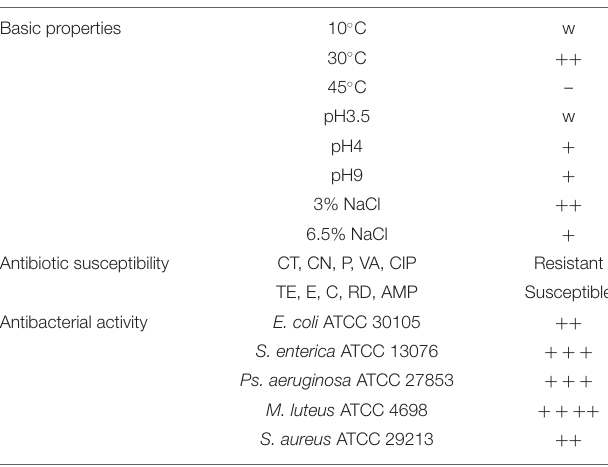
TABLE 1 | L. casei ZX633